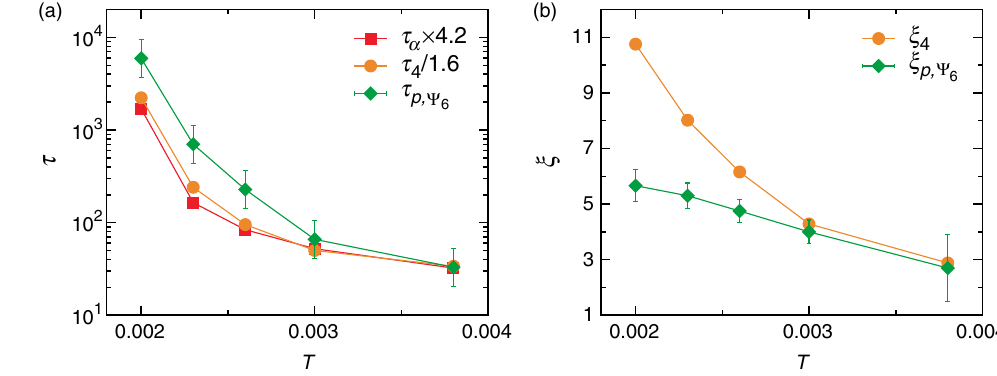
FIG. 9. Time and length scales in the structure-dynamics correlations according to direct motions in 2D polydisperse system ( Δ ¼ 11% ). (a) Temperature dependences of the α relaxation time τ α , the timescale of dynamic heterogeneity τ 4 , and τ (b) Temperature dependences of the dynamic length scale ξ 4 and ξ removing the Mermin-Wagner-type fluctuations.